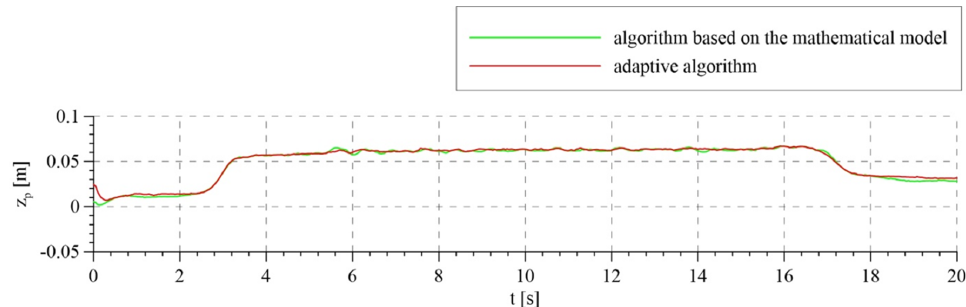
Figure 11. Disturbance of the system—displacement of the patient’s torso.